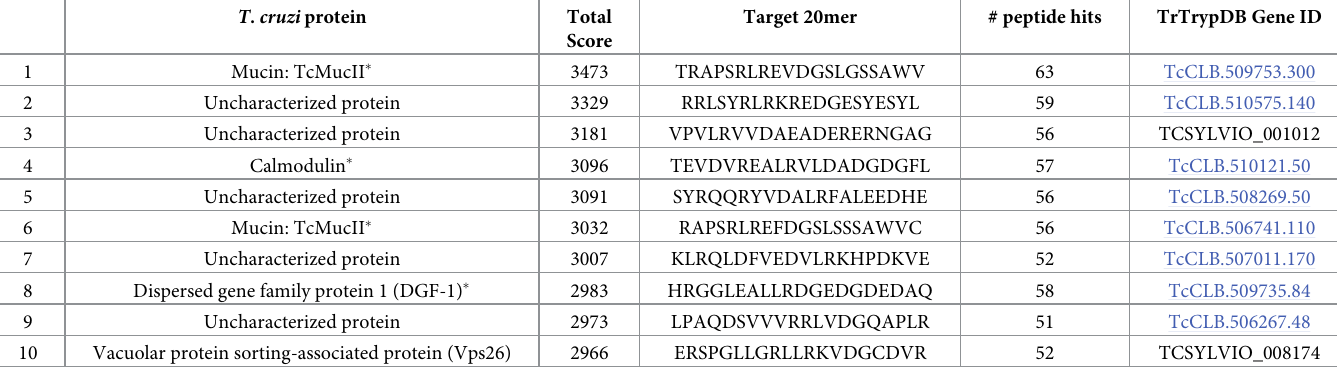
Table 3. Top ranking alignments of informative library peptides to the T . cruzi proteome.